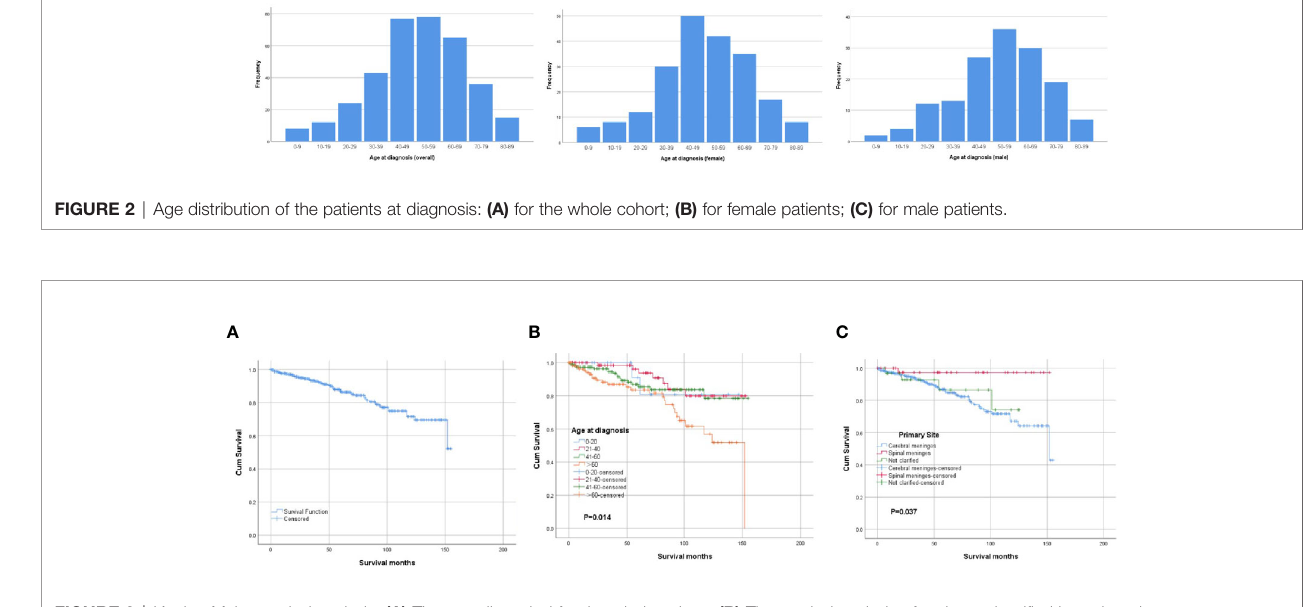
FIGURE 3 | Kaplan-Meier survival analysis: (A) The overall survival for the whole cohort. (B) The survival analysis of patients classi fi ed based on the age at diagnosis. (C) The survival analysis of patients classi fi ed based on the primary tumor site.